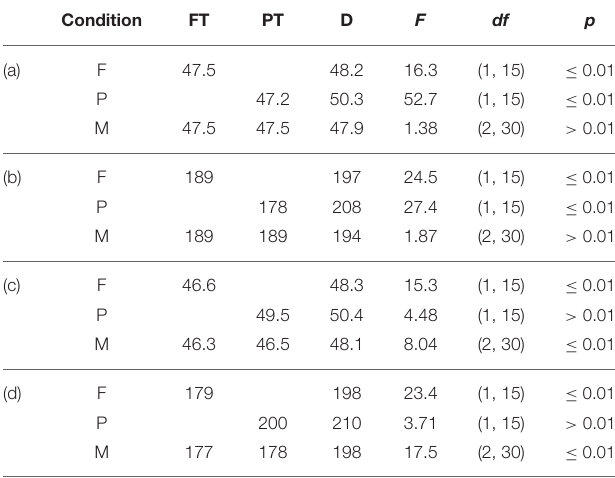
TABLE 4 | Average duration in milliseconds (a) and distance in pixels (b) of the saccades toward foveal (FT) and peripheral targets (PT) and distractors (D).